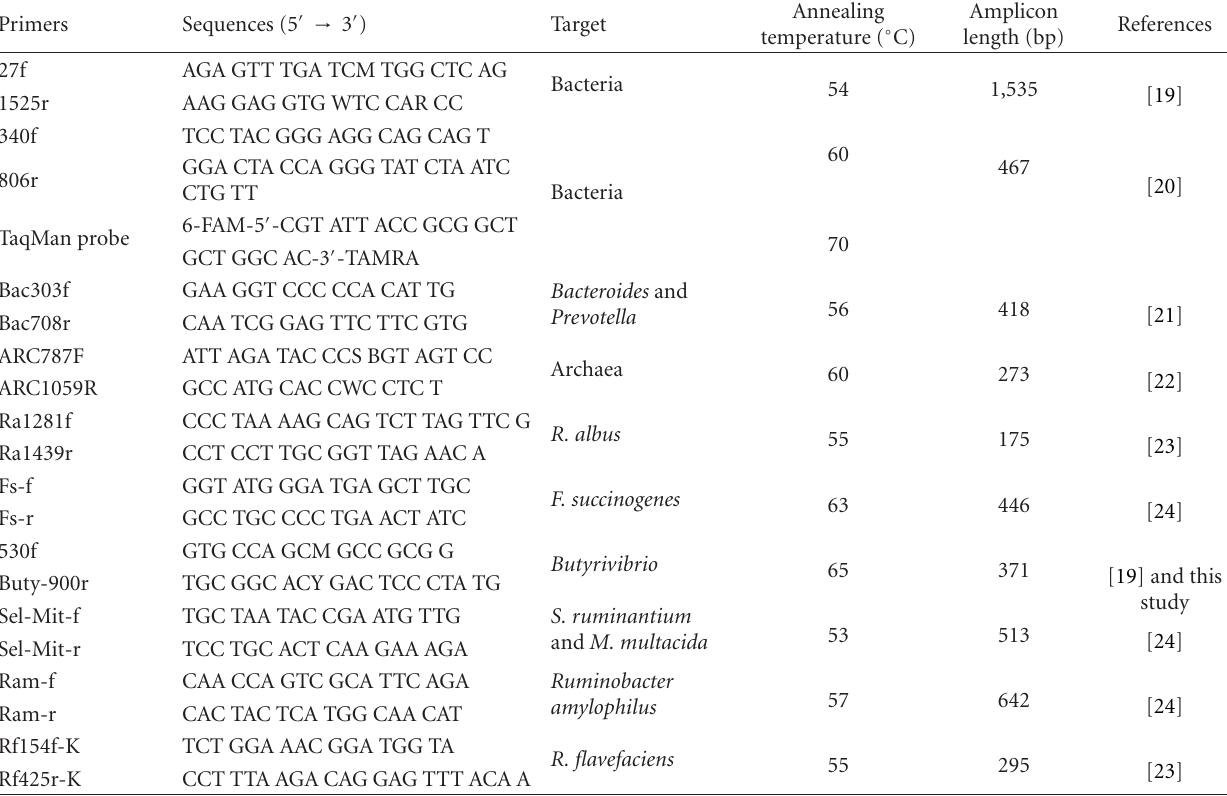
Table 2: Primers and probe used for real-time PCR quantification of recognized rumen bacterial species, genera, or uncultured bacteria.